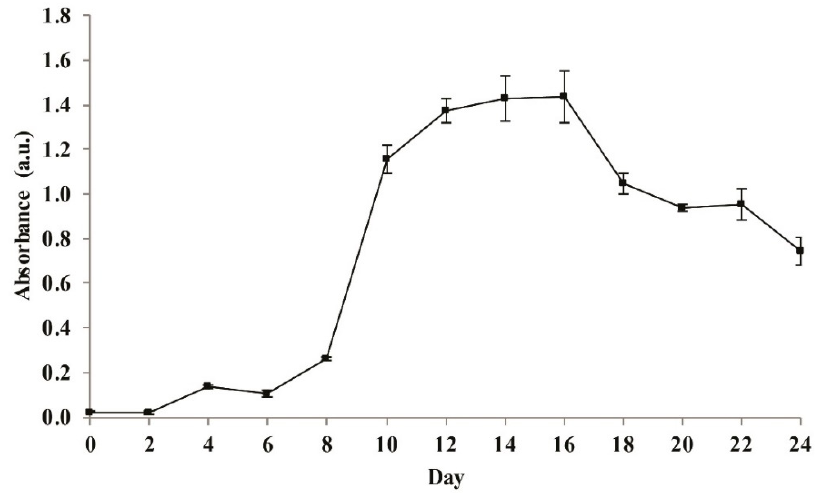
Figure 3. The phototrophic growth curve of Cyanosarcina sp. AARL T020 in the BG11 medium. Y = 0.9224 + 0.0572X 1 + 0.0853X 2 + 0.0186X 3 − 0.0037X 1 X 2 − 0.0137X 1 X 3